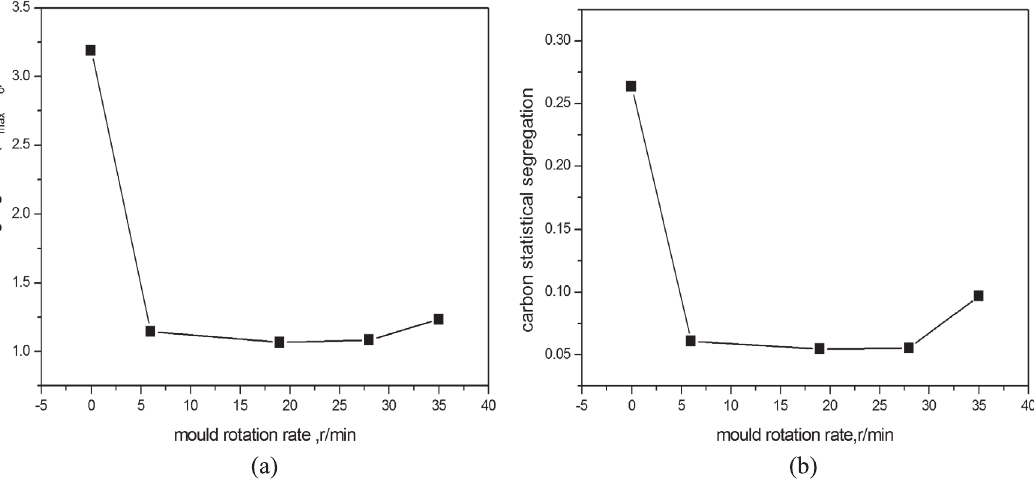
Fig. 4: (a) Relation between maximum carbon segregation (C max /C o ) and mould rotation rate. (b) Relation between carbon statistical segregation and mould rotation